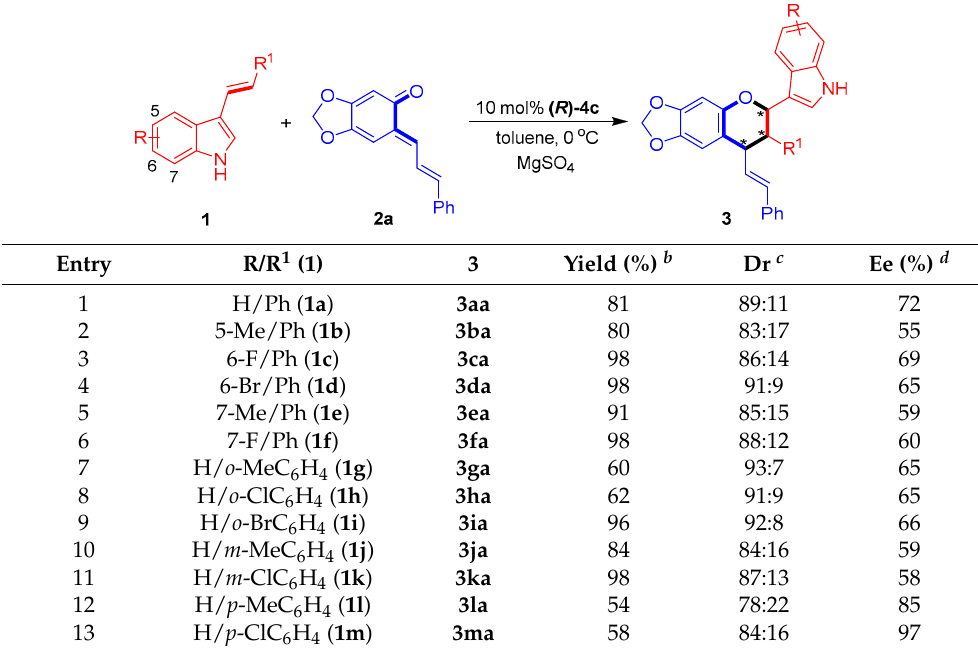
Table 4. Substrate scope of o -QMs 2 a